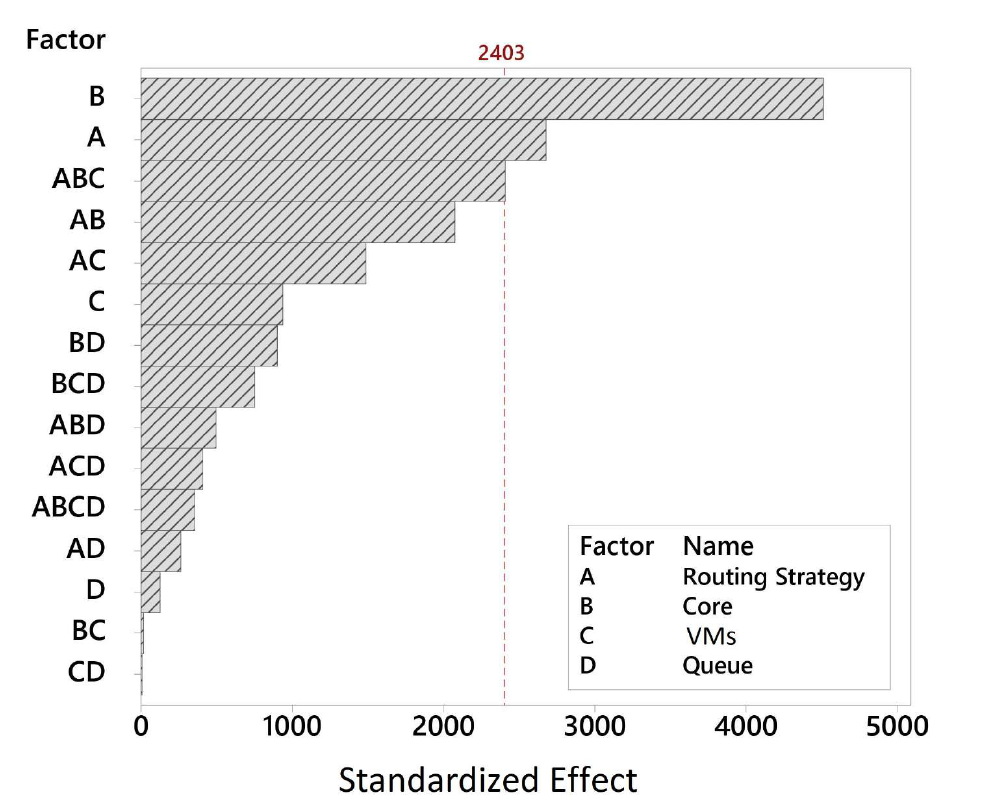
Figure 4. Impact of different factors on the MRT metric (response is the MRT (milliseconds), ( α = 0.05 ) ).